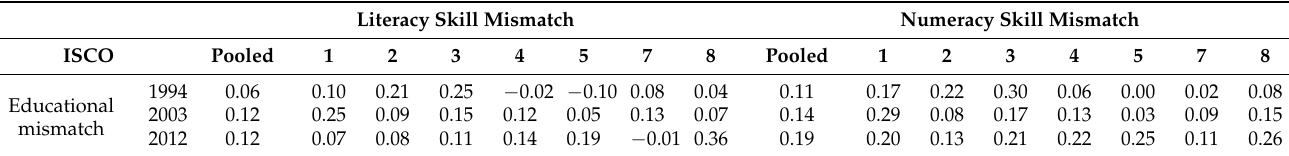
Table 3. Correlation between educational and skill mismatch by occupational level. Literacy Skill